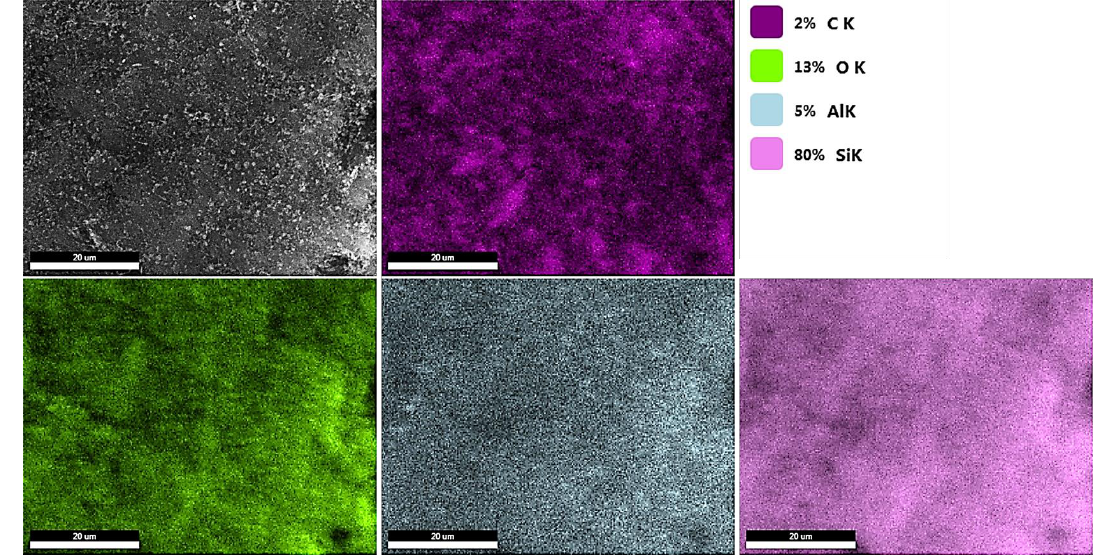
Figure 2. EDS analysis of the NHYZ/CNS catalyst, scale bar = 20 µm.